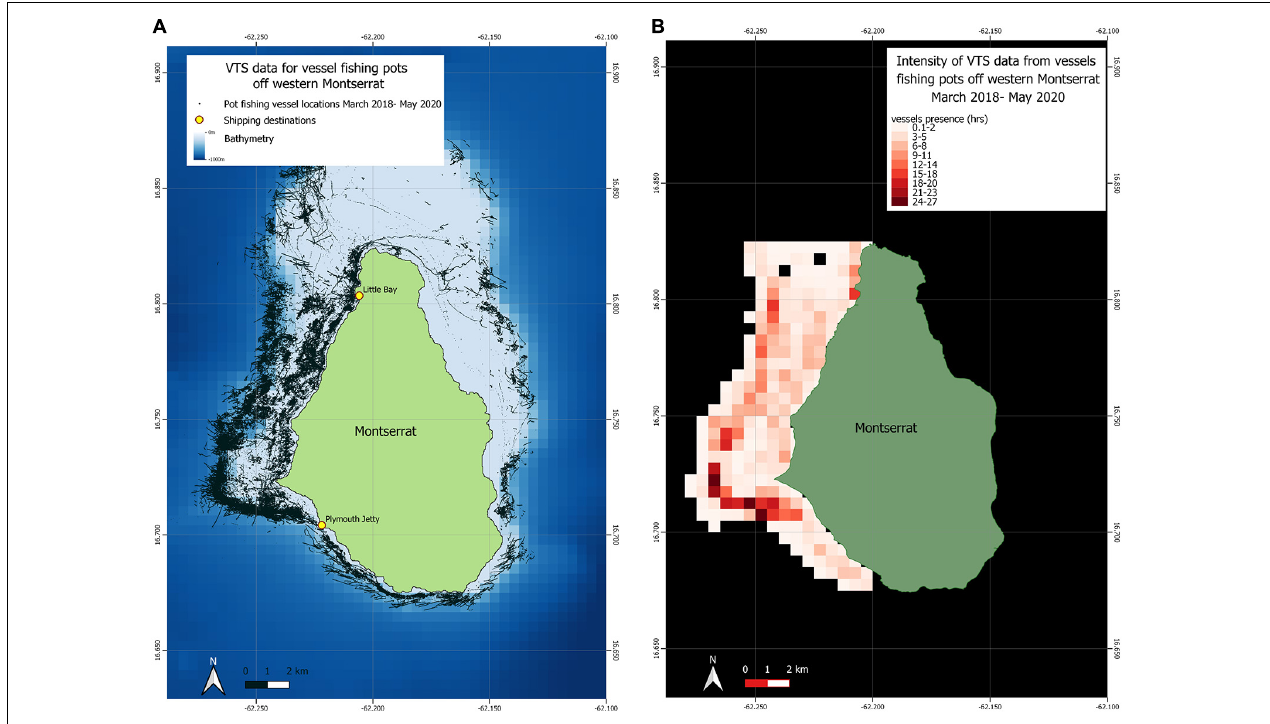
FIGURE 3 | (A) Raw point data of pot fishing vessel activity off western Montserrat. (B) Intensity map of pot fishing vessel activity off western